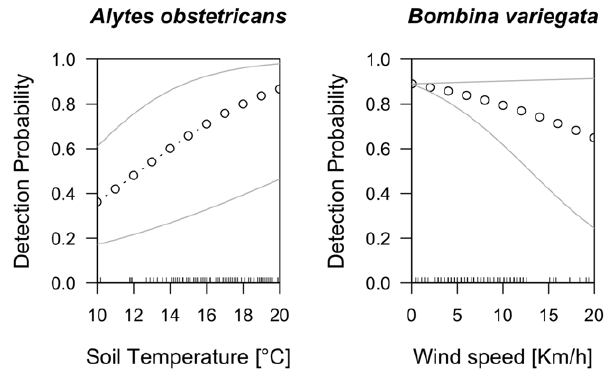
Figure 1. The relationship between meteorological variables and detection probabilities in two anurans. Thin gray lines are 95% confidence intervals. Small ticks inside the box indicate observed soil temperatures and wind speeds,